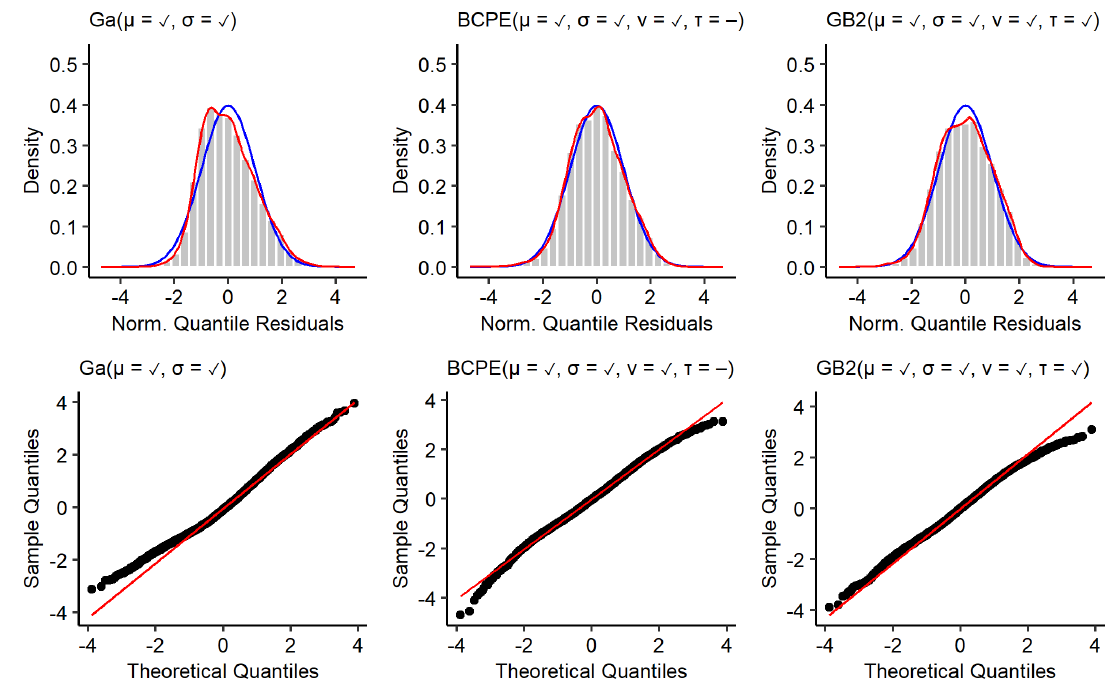
Figure A2. Residuals of models estimated with the female training data. Top : histogram and kernel density estimate of normalised quantile residuals with standard normal distribution (blue). Bottom : Quantile–quantile